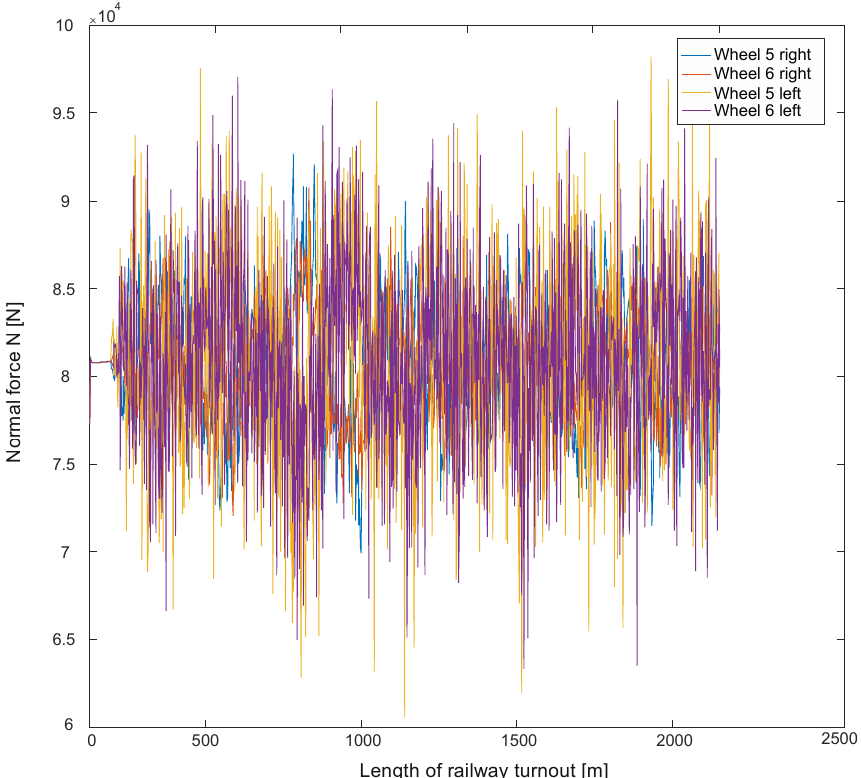
Figure 25 . Normal force at 300 km/h on a straight track without a turnout .